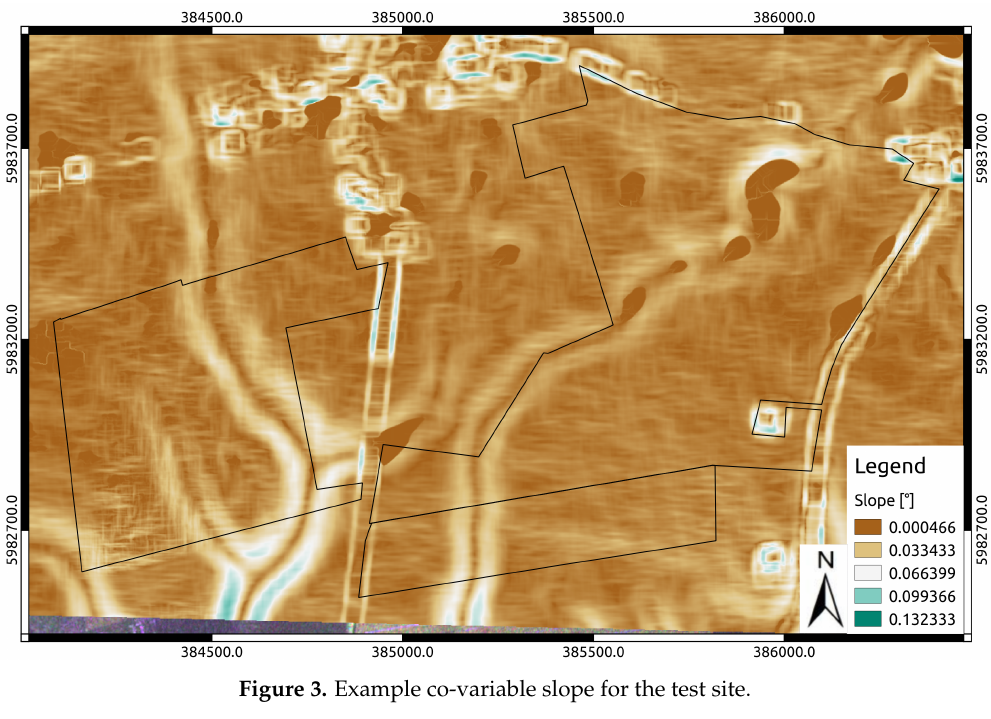
Figure 3. Example co-variable slope for the test site.